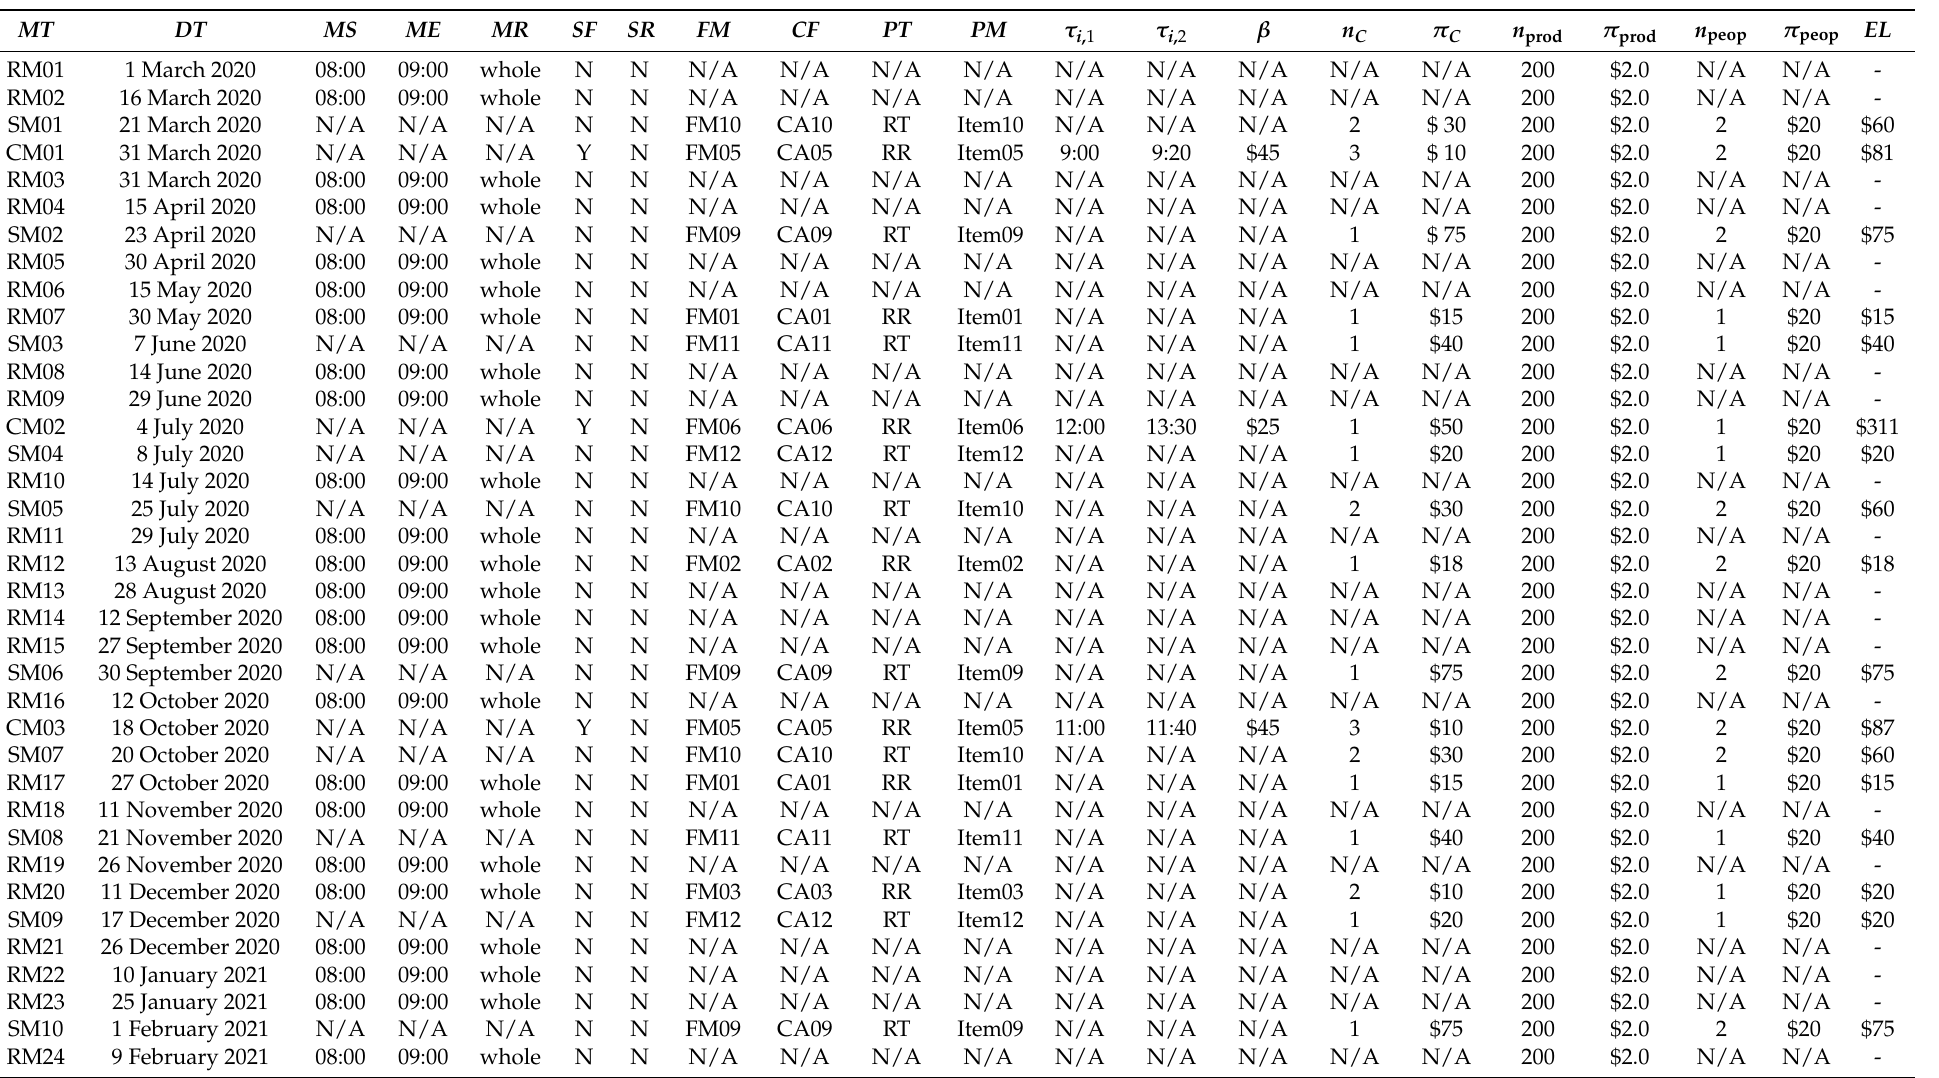
Table A2. Maintenance record data for the EL-FMEA for case